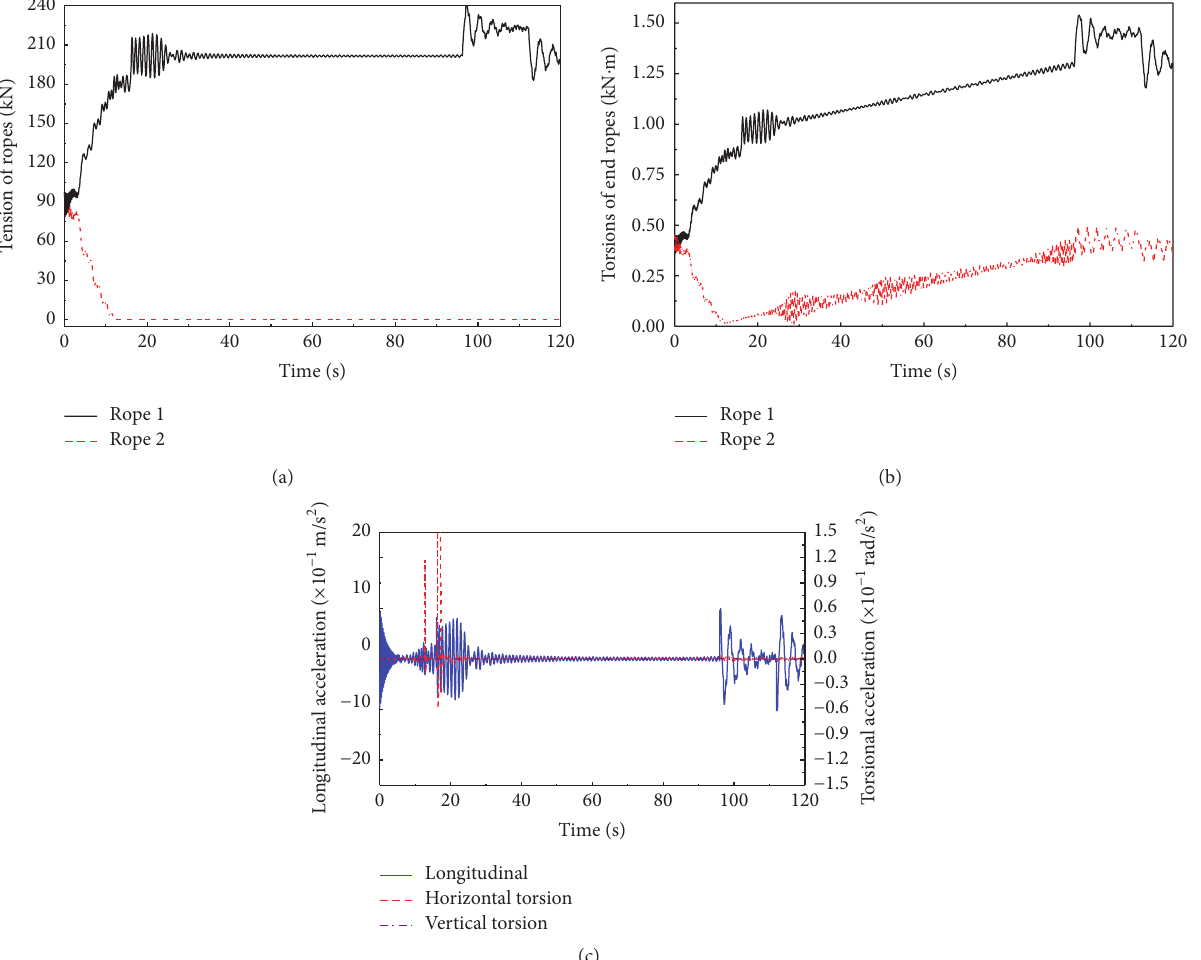
It should be noted that the torsions of two ropes increase even if the tension of one rope drops gradually or the rope is slack. The drive deviation (only 1/1000 of the radius)